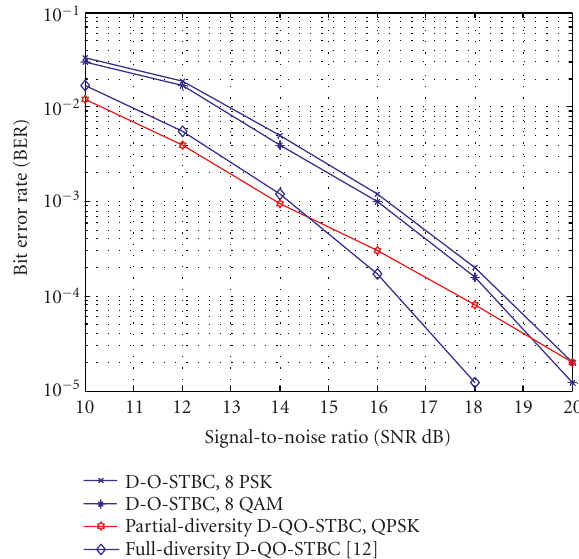
Figure 2: Di ff erential QO-STBC schemes at rate 1.5bps/Hz, eight transmit